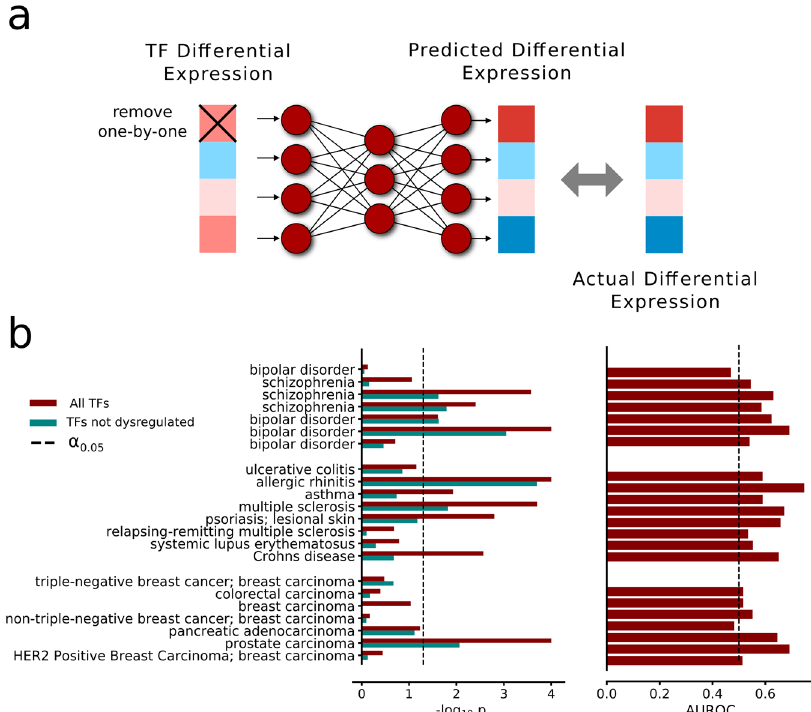
Fig. 5 Predicting gene dysregulations in disease using a DNN. a We tested if the DNN with two hidden layers of 250 hidden nodes each could be used to predict causative changes in disease states. We did this by analyzing gene expression changes from known diseases, as available in the Expression Atlas repository. By applying the disease changes to the transcription factor input layer, we could observe how these changes projected down to the target genes. Next, we removed the disease-fold changes of each TF independently and observed the changes in correlation between predicted and observed dysregulation of the target genes. Thus, we could rank the TFs on predicted causative disease changes on the target genes. b TF rankings signi fi cantly overlapped with GWAS in 10 of 22 diseases. ( − log 10 P values shown as red bars). The test was repeated with signi fi cantly differentially expressed TFs removed from the set, leaving 7 TF rankings to overlap with GWAS. ( − log 10 P values shown as teal bars). The corresponding area under the curves for the TF rankings (all TFs) are shown to the right, with 20 of 22 diseases having an AUROC greater than the expected, as generated under the null